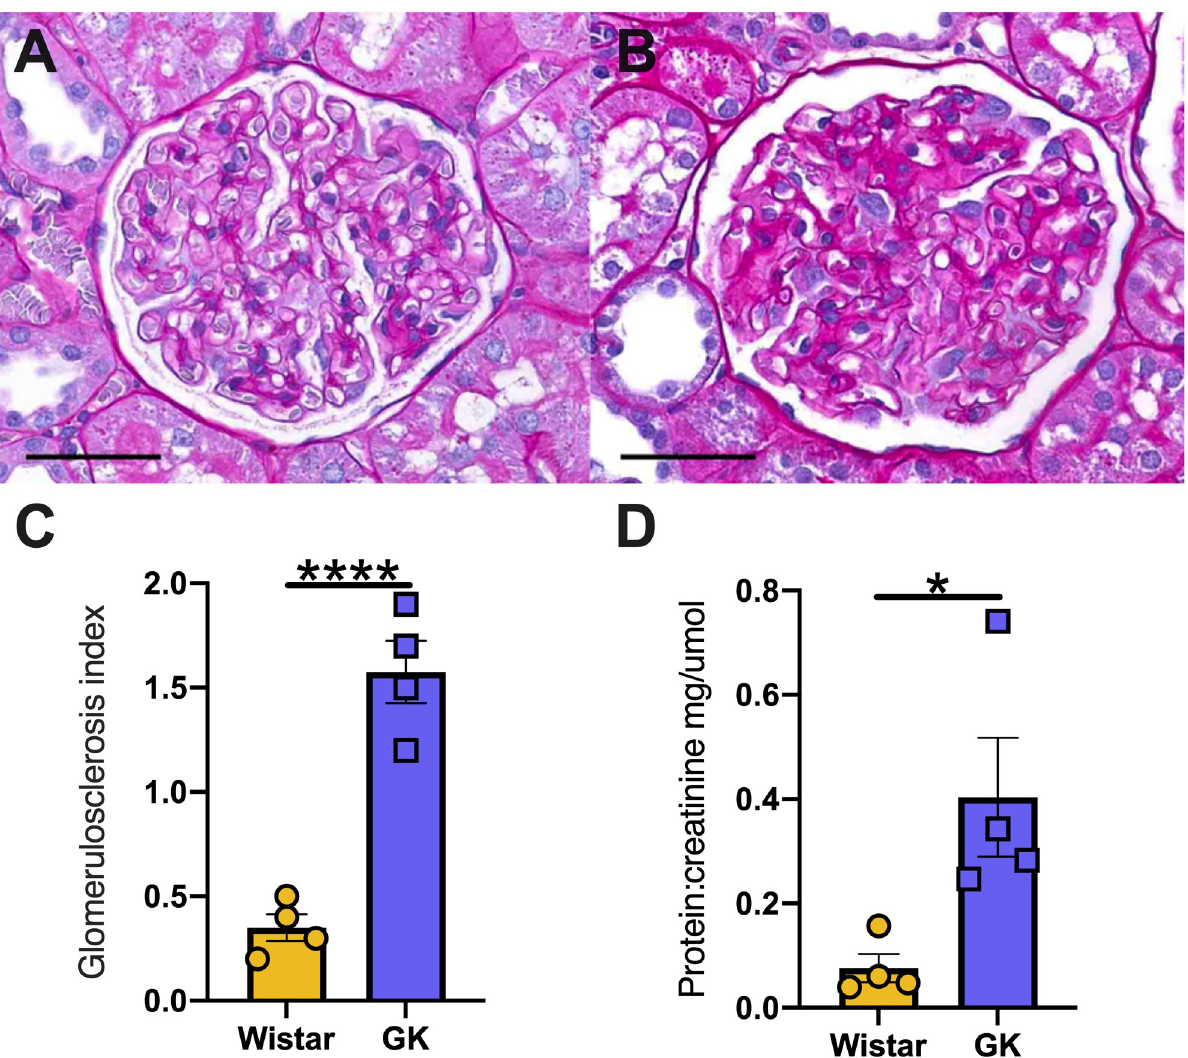
Fig 4. Kidney structure and function in Wistar and GK at the late time point. Representative PAS images of Wistar (A) and GK (B) kidneys at 48 weeks, respectively. Glomerulus score index (C) and analysis of protein: creatine (D) at 48 weeks of ages. � = p < 0.05, ���� = p < 0.0001 when compared to Wistar rats; (students t-test was used to assess statistical significance). Yellow = Wistar and Blue = GK. Data is expressed as mean ± SEM N = 4–8 per group. Scale bars 50 μ m.